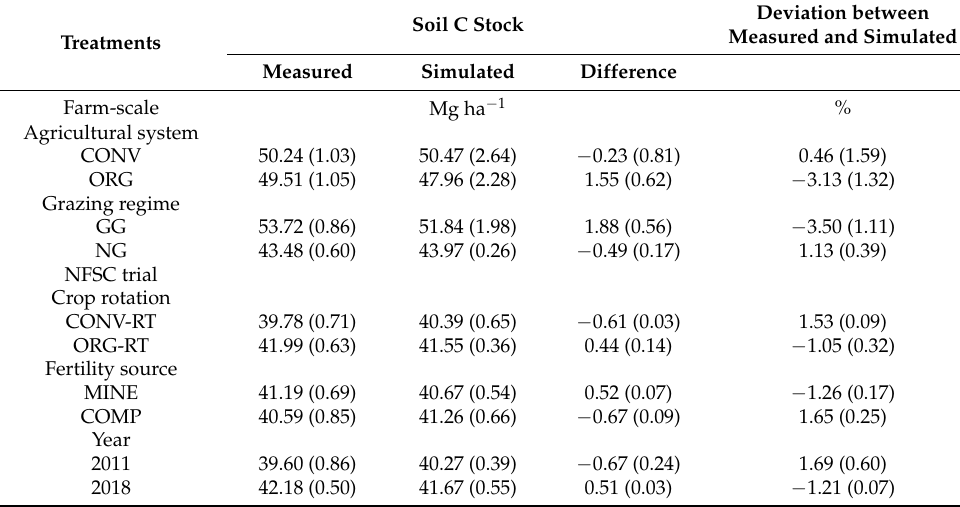
Table 2. Measured and simulated soil C stocks at 0–0.20 m depth for the farm-scale study, en- compassing agricultural system (conventional—CONV and organic—ORG) and grazing regime (non-grazed—NG and grazed—GG), and for the Nafferton Factorial Systems Comparison (NFSC) trial treatments, including crop rotation (conventional—CONV-RT and organic—ORG-RT), fertility source (mineral—MINE and compost—COMP) and year of sampling (2011 and